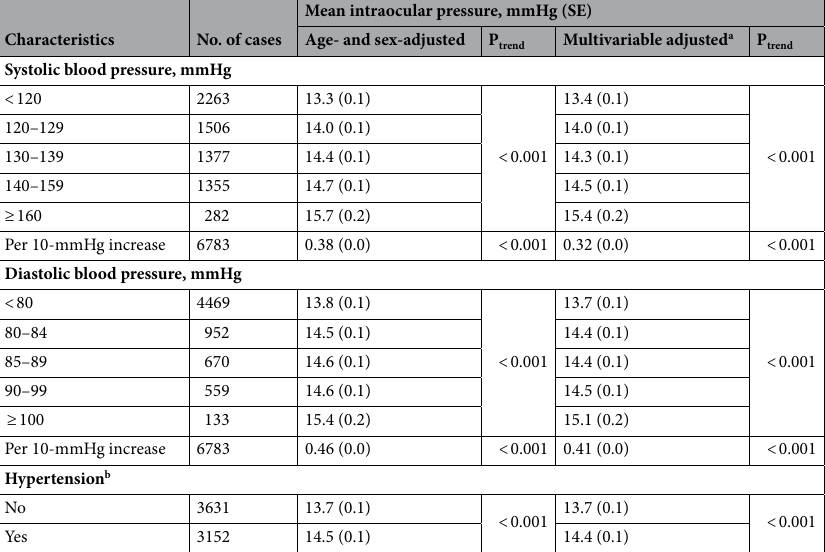
Table 2. Adjusted mean intraocular pressure according to systolic and diastolic blood pressures and hypertensive status. LDL, low-density lipoprotein; SE, standard error. a Adjusted for age, sex, smoking status, alcohol intake, diabetes, body mass index, LDL-C level, and central corneal thickness. For systolic blood pressure and diastolic blood pressure, we have additionally adjusted for use of any antihypertensive medication. b Hypertension was defined as use of any antihypertensive medication, systolic blood pressure ≥ 140 mmHg, and/or diastolic blood pressure ≥ 90